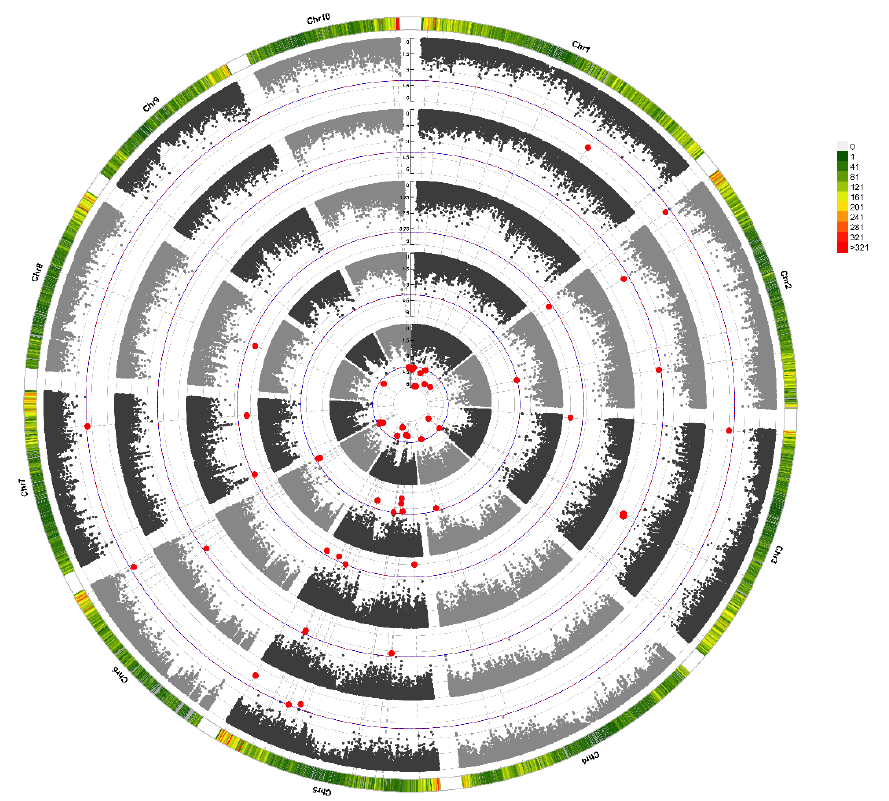
Figure 4. Circular Manhattan Plot. Red dots are significant SNPs for corresponding senescence traits. From inside to out: VSH — visual scale of husk leaves at 45 DAA; VSP — visual scale of plant at 45 DAA; SC — stomatal conductance; PHVDIF — the difference between the visual scale of plant and husk at 45 DAA; PA — photosynthesis activity at 45 DAA.